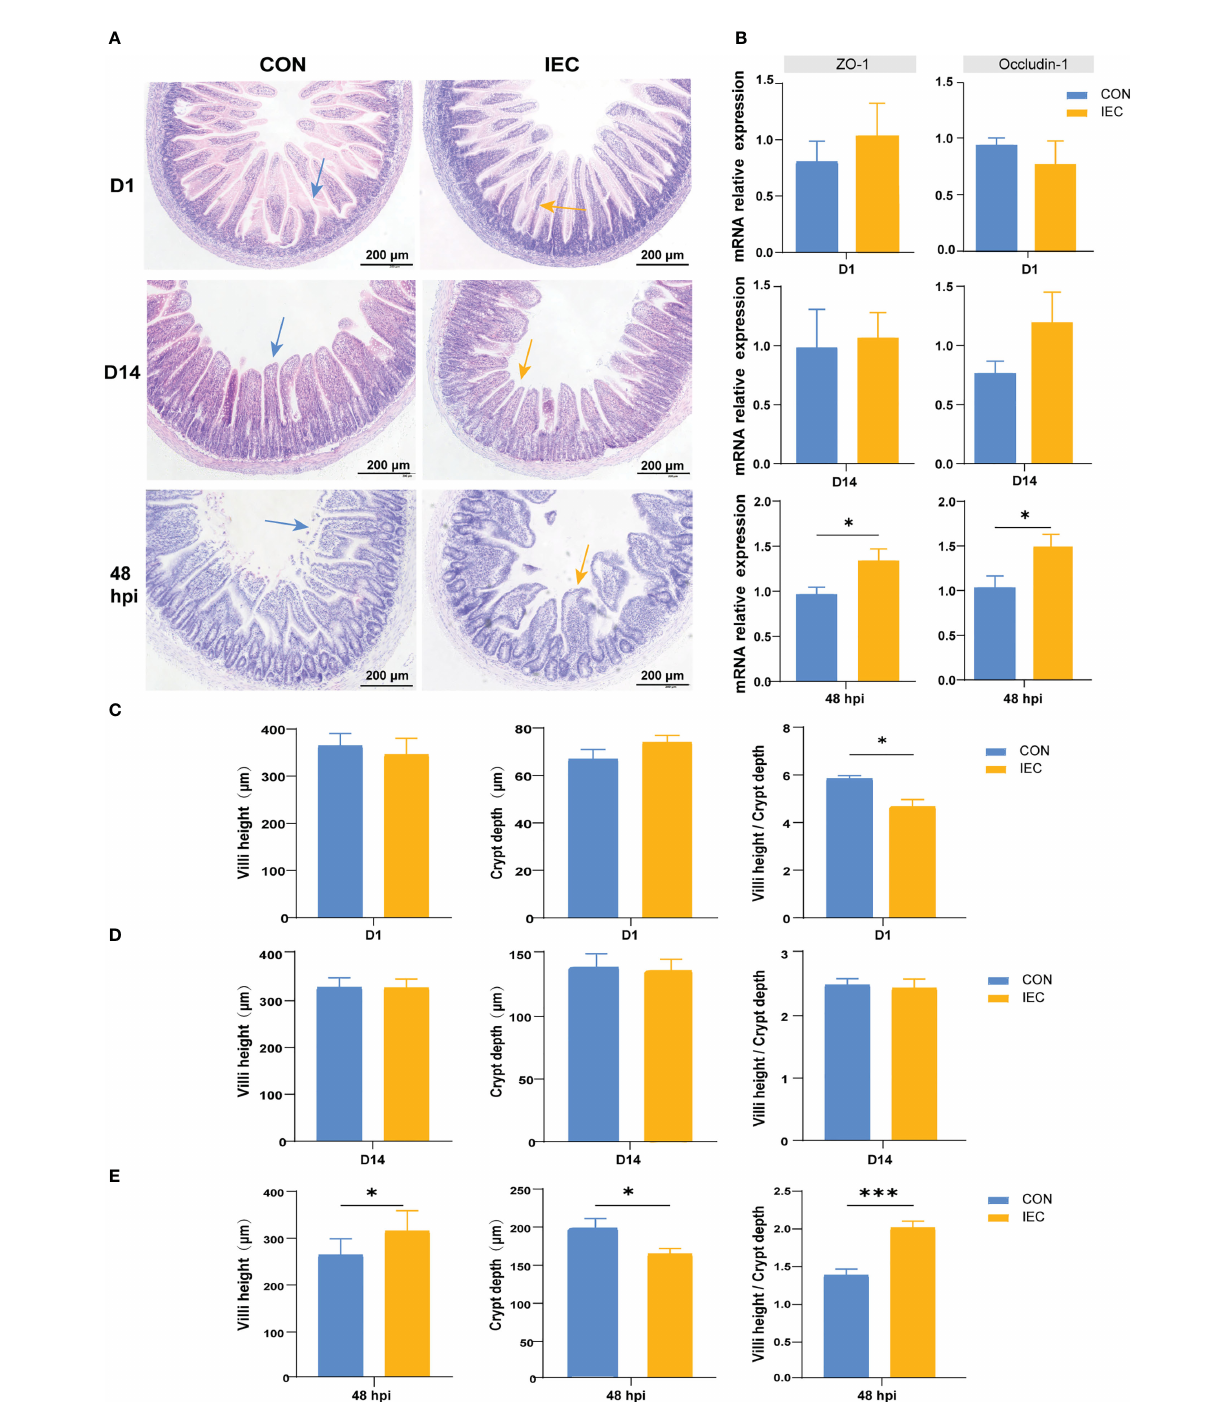
FIGURE 3 Pathological, changes of intestinal villus and crypt and the relative genes expression in two groups in different period. (A) Intestinal morphology shown of the ileum tissues of rat in different period (n = 4~10/group). (B) The gene expression of intestinal barrier function (n = 4~10/group). (C-E) Histological evaluation of ileum between two groups of rats in different period (n = 4~10/group). The data are presented as mean ± SEM. Asterisks indicate signi fi cant difference between the IEC group and the CON group (* P < 0.05; *** P < 0.001). ZO-1 , Zonula